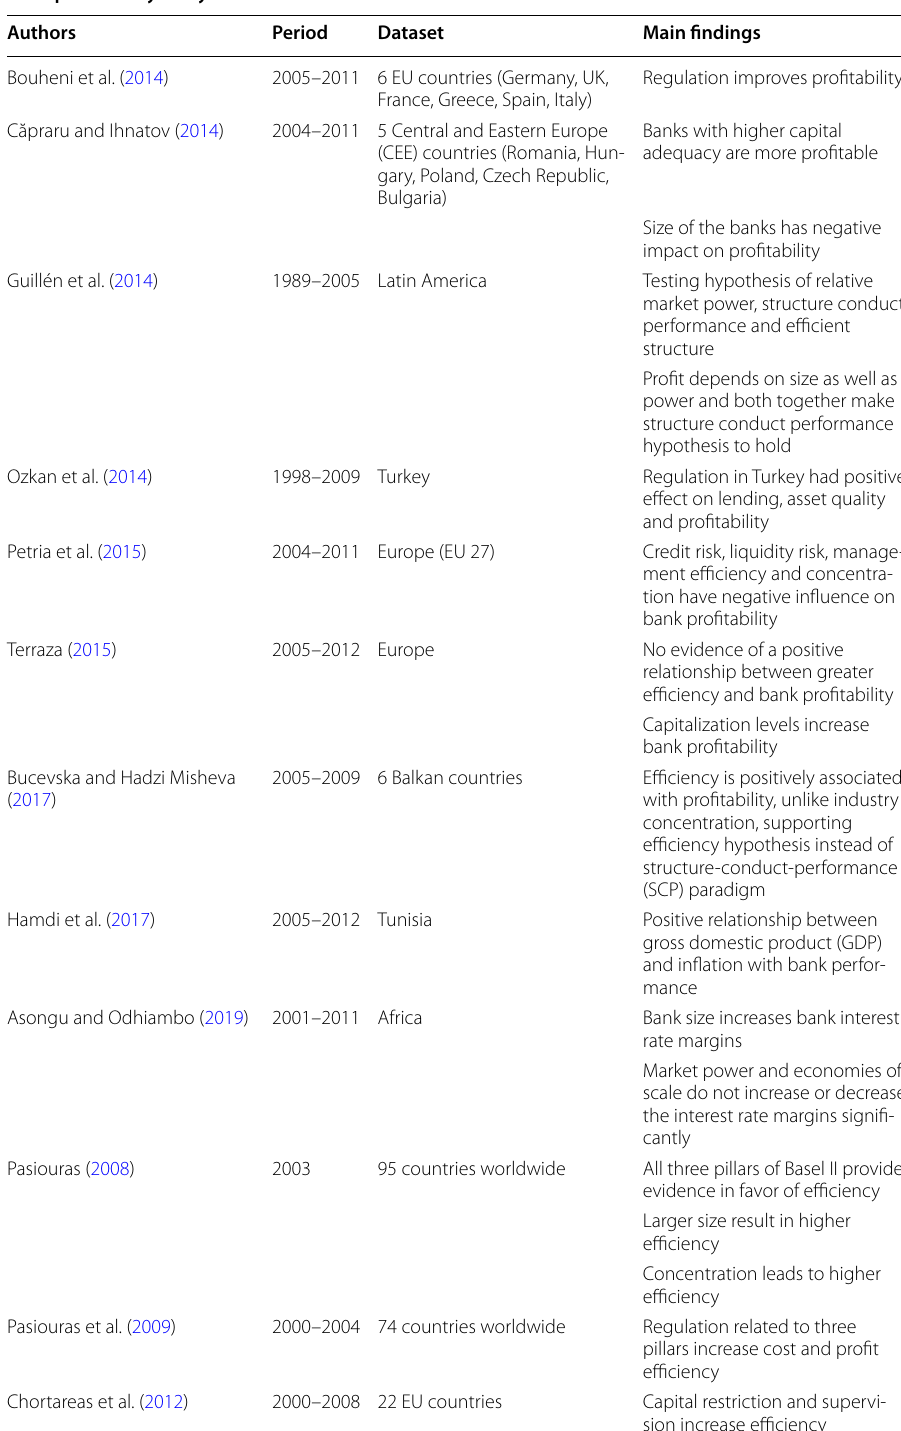
Table 1 Studies on bank performance (profitability and